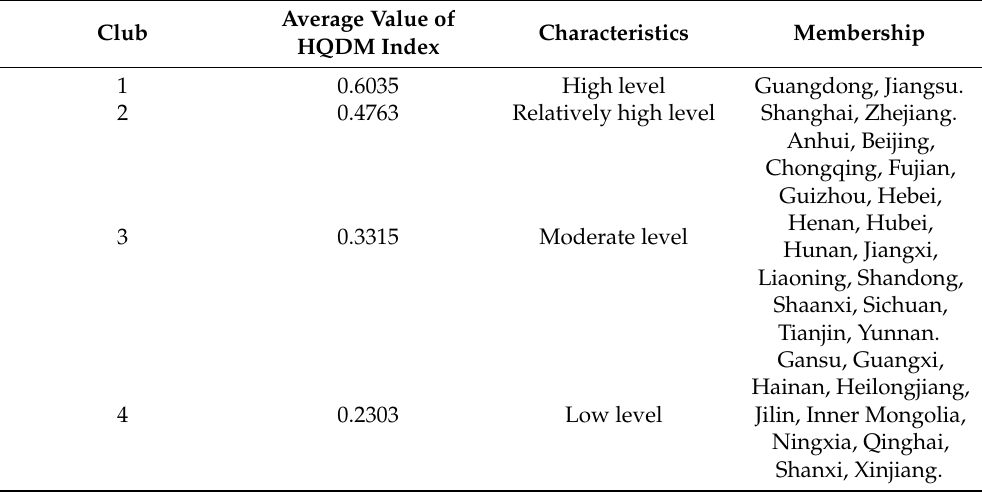
Table 5. Basic characteristics of convergence